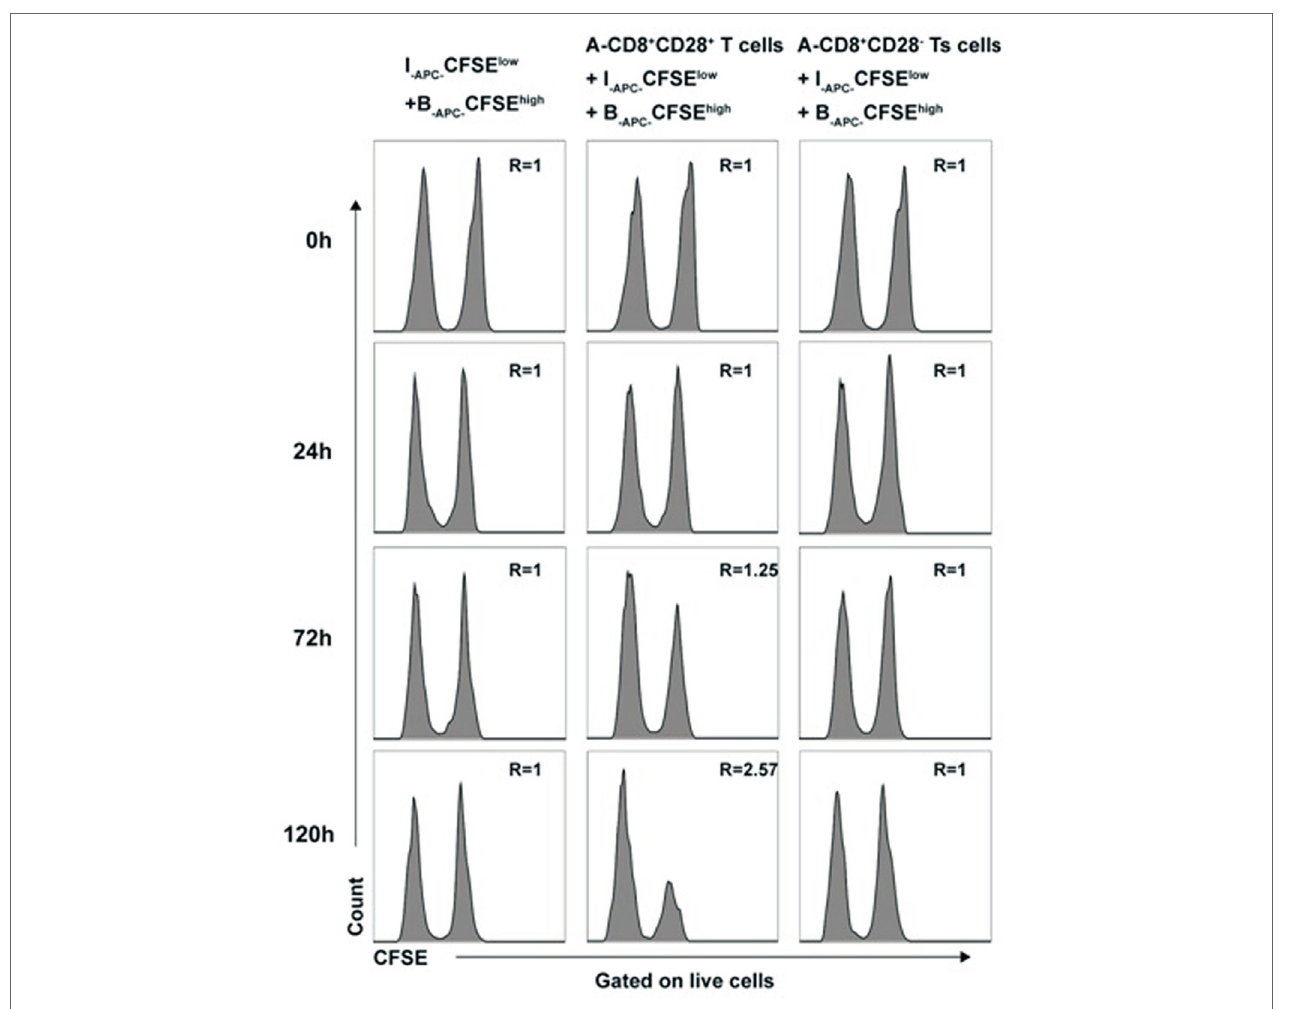
FigUre 5 | Cytotoxicity does not contribute to the allospecific suppression of CD8 + CD28 − T cells expanded in vitro B -APC- CFSE high [priming antigen-presenting cells (APCs) from donor B, were labeled with a high concentration (2.0 µM) of carboxyfluorescein diacetate succinimidyl ester (CFSE)] and I -APC- CFSE low [APCs from indifferent individual I, labeled with a low concentration (0.2 µM) of CFSE] were cocultured in a mixture of 1:1 by themselves or either with the same number of CD8 + CD28 + T cells (middle panels) or CD8 + CD28 − Ts cells (right panels) in 96 U -bottom plates in triplicates. At 0, 24, 72, and 120 h of culture, cells were collected and analyzed by FACS. The ratio of cell numbers of I -APC- CFSE low vs B -APC- CFSE high was calculated as “ R ” for all time points. An increase in the value of R indicates specific killing of B -APC- CFSE high cells by the putative effctor cells, whereas a stable value of R at 1.0 indicates no specific killing of B -APC- CFSE high cells. Data shown are representative of three independent experiments.